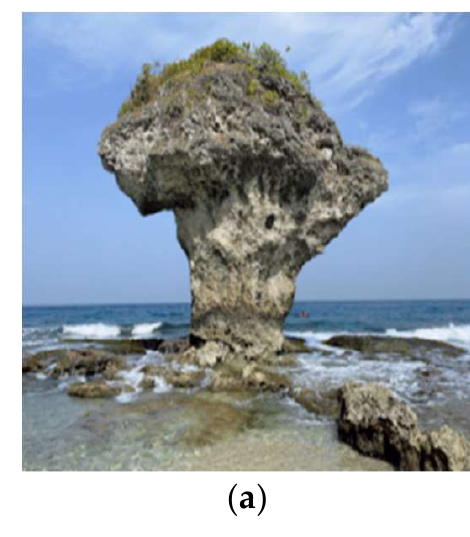
Figure 2. A small island, Xiaoliuqiu, become an important destination during COVID-19. ( a ) Vase Rock, a very popular attraction where tourists visited and snorkeled; and ( b ) Sea turtle, which could be seen closely during early mornings. All the photos showed the students not only as tourists but also as ecological learners when they observed the landscape without affecting the sea wildlife.